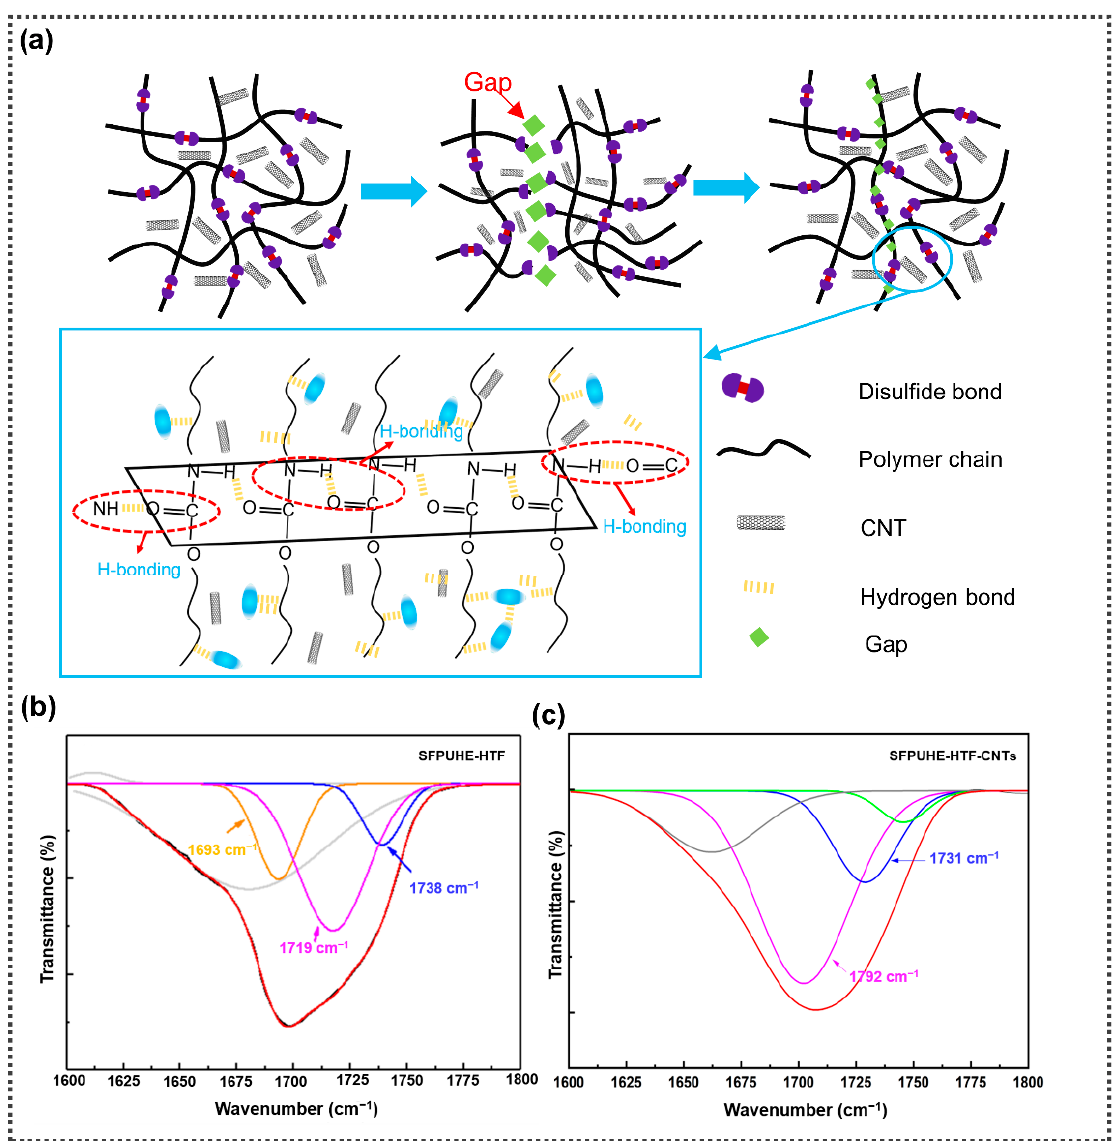
Figure 5. ( a ) Schematic diagram of the self-healing mechanism of SFPUHE-HTF-CNTs; ( b ) the FT-IR Gaussian split-peak plots of SFPUHE-HTF; ( c ) the FT-IR Gaussian split-peak plots of SFPUHE-HTF-CNTs.